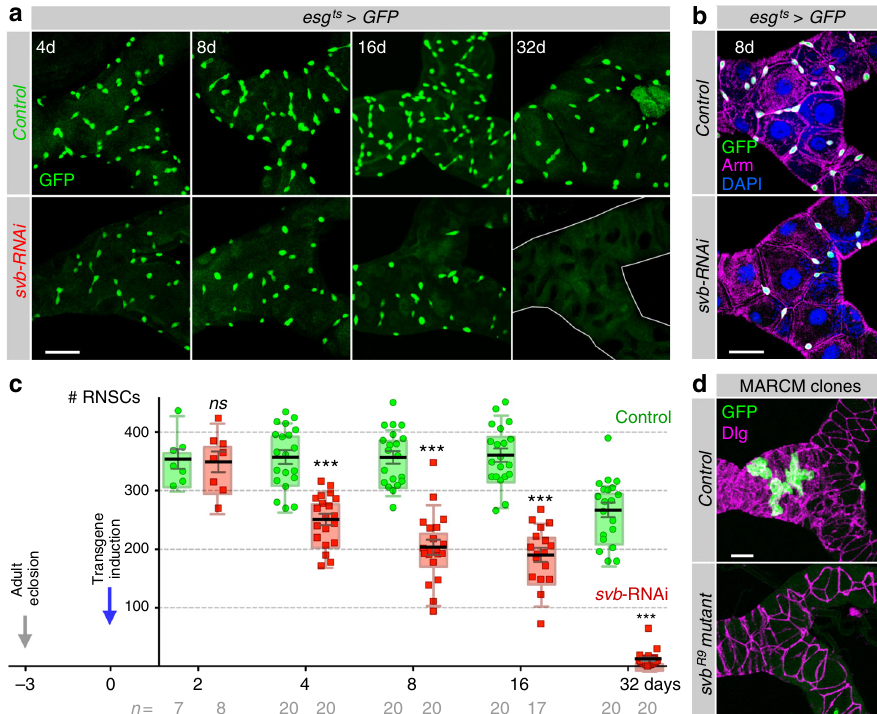
Fig. 2 svb is required for RNSC maintenance. a esg ts -driven svb-RNAi leads to a progressive decrease of RNSC number compared to controls ( esg ts driving only GFP). b svb depletion eliminates RNSCs, without affecting typical features of remaining stem cells, e.g., esg expression and Arm accumulation (see also Supplementary Figure 2). c Quanti fi cation of the number of RNSCs ( esg -positive) after 2 ( p = 0.9551), 4 ( p < 0.0001), 8 ( p < 0.0001), 16 ( p < 0.0001), and 32 days ( p < 0.0001) of transgene induction in control (green) and svb-RNAi (red) conditions. d MARCM of control and svb R9 clones, positively labeled with GFP (green), 25 days after clone induction. See Appendix for full genotypes. In this and all subsequent fi gures, each dot corresponds to an independent sample; results were combined from at least two independent experiments. Values are presented as average ± standard error of the mean (SEM) and boxes with whiskers (10 – 90 percentile). p -Values from Mann – Whitney test (ns, p ≥ 0.05; * p < 0.05; ** p < 0.01; *** p < 0.001). Scale bar is 30 µ